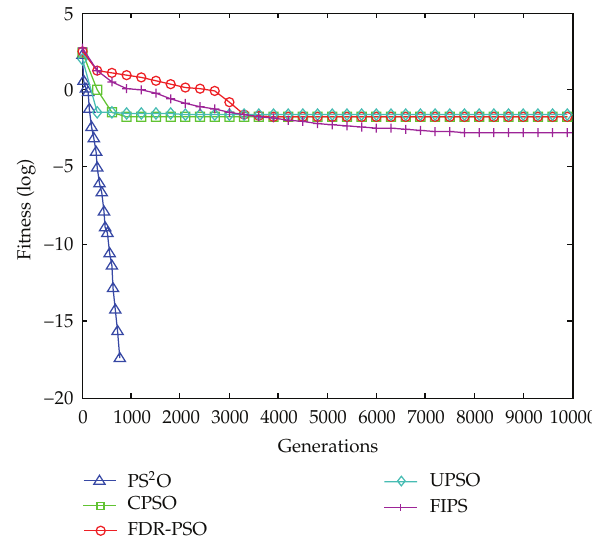
Figure 7: The median convergence results of Griewank function.